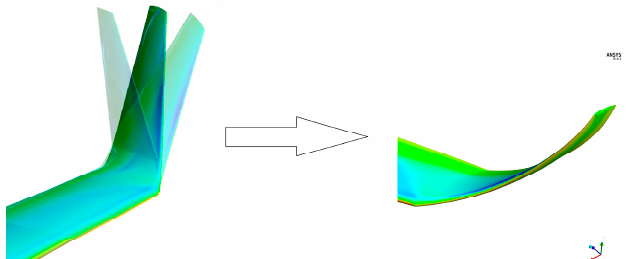
Figure 14. The concept of curved winglet provides an alternative to a much more complex and structurally heavier variable-cant, morphing